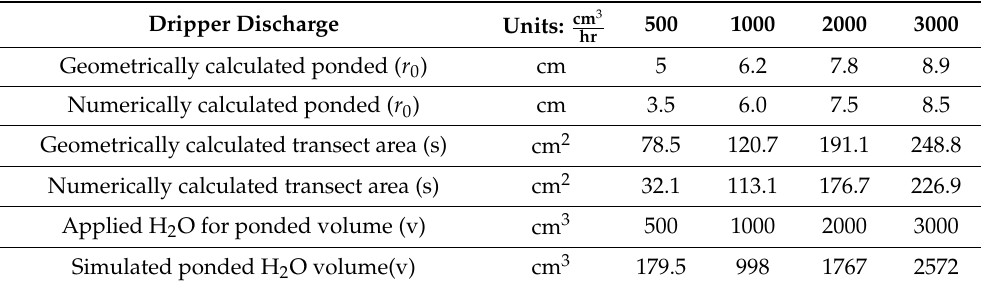
Table 4. Large-time radius of SDI sphere, its volume and its surface area as a function of drippers discharge. Total water application was 3000 cm 3